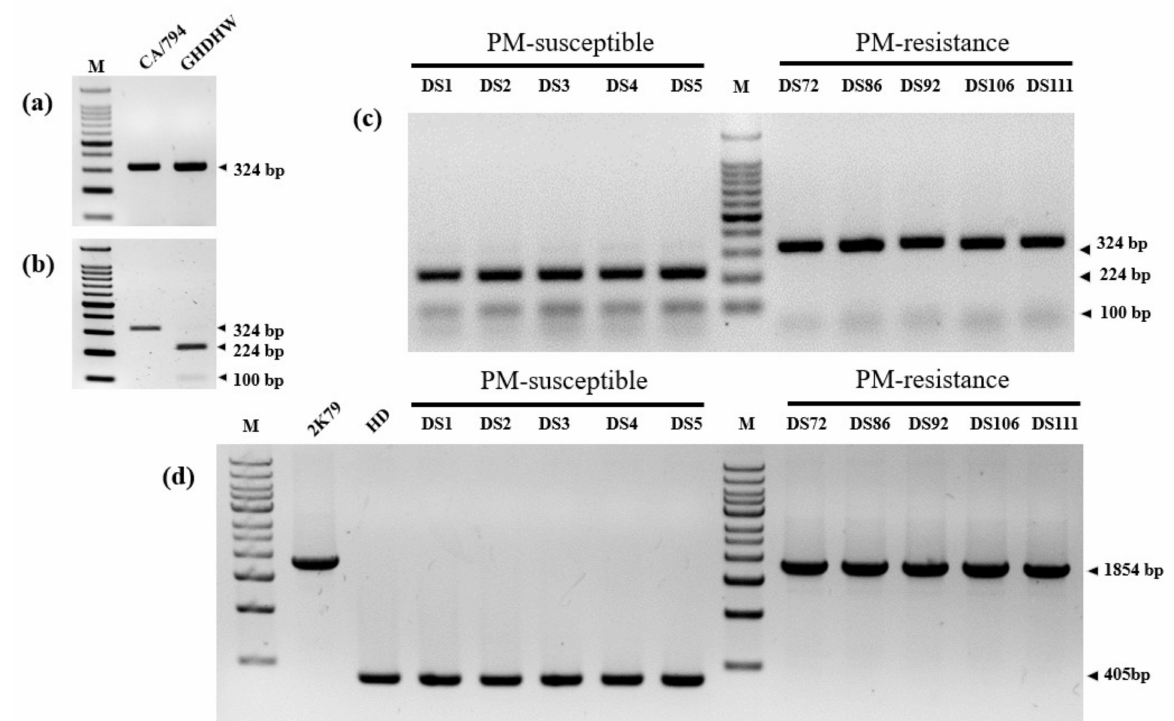
Figure 3. Genotyping analysis of parental and inbred lines using CsLRR-RPK2 -CAPS and CsaMLO8 -InDel markers. ( a ) represents the bands amplified by CsLRR-RPK2 -CAPS primers. ( b ) Represents the band patterns after application of HinfI enzyme. ( c ) Represents the application of CsLRR-RPK2 -CAPS marker to the 10 inbred lines (5 PM-resistance and 5 PM–susceptible inbred lines). ( d ) Represents the bands of parental lines amplified by CsaMLO8 -InDel primers and application to the 10 inbred lines (5 PM-resistant and 5 PM-susceptible inbred lines). M, CA794, 2K79, GHDHW, and HD represent the molecular markers (100 bp and 1 kb), PM resistant (CA/794 and 2K79), and PM-susceptible (GHDHW and HD) parental lines, respectively. DS1, DS2, DS3, DS4, DS5 and DS72, DS86, DS92, DS106, and DS111 represent the inbred lines of PM-susceptible and PM-resistant lines, respectively. The digits next to the black arrows represent the size of the PCR